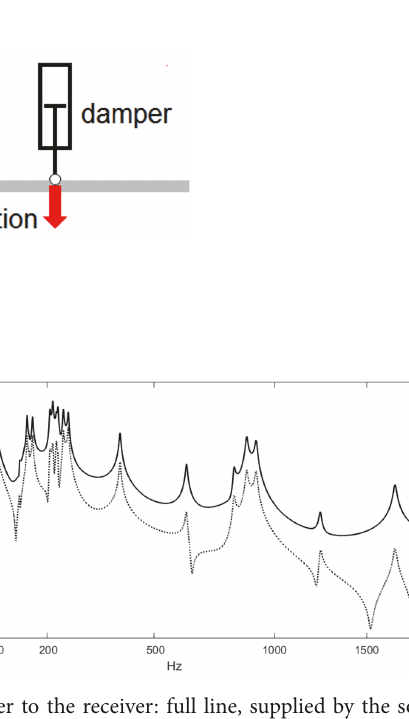
Figure 9: Power to the receiver: full line, supplied by the source; dotted line, absorbed by the